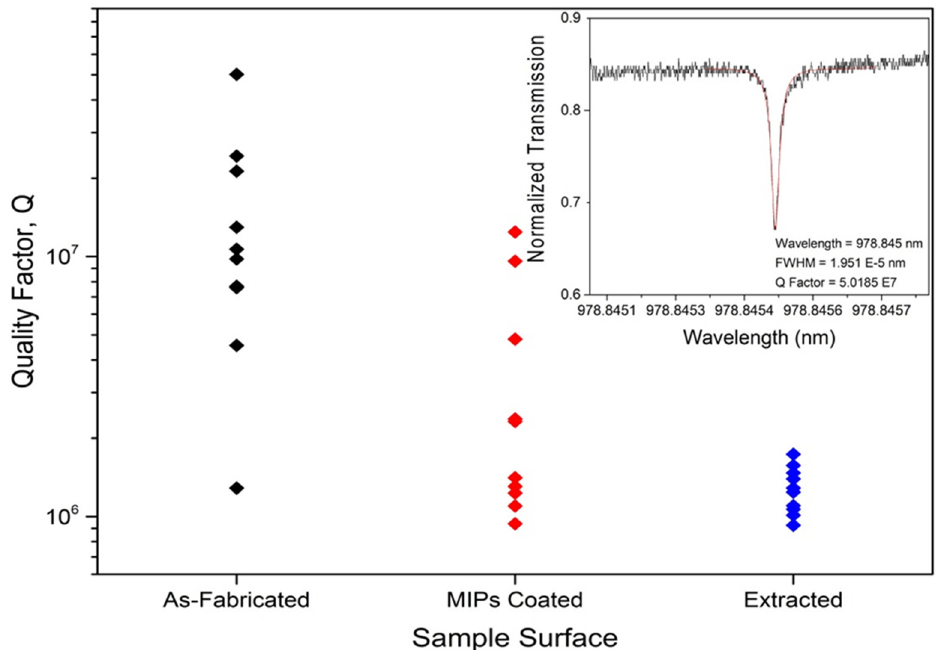
Figure 12. Q factors of all 10 spheres from Dish 22 and 23 taken as-fabricated, MIPs coated, and after the extraction process. The inset depicts the fundamental peak of an as-fabricated sphere with a Lorentzian fit curve; the Q factor was 5.0185 × 10 7 . As you can see the Q factor decreases at with each step in the procedure; and interestingly with a decrease in Q factor but less deviation after extraction.